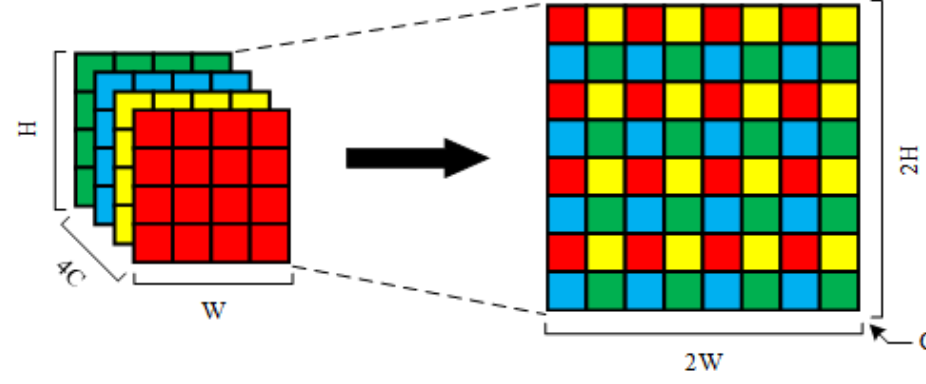
Figure 2. Schematic diagram of the pixel